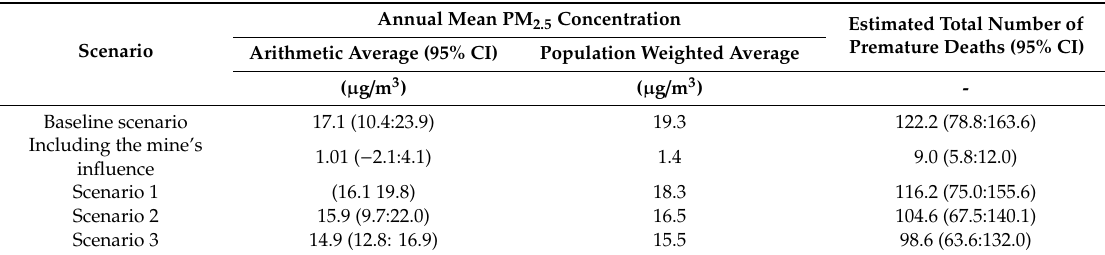
Table 7. PM 2.5 concentration and related premature deaths calculated for emission